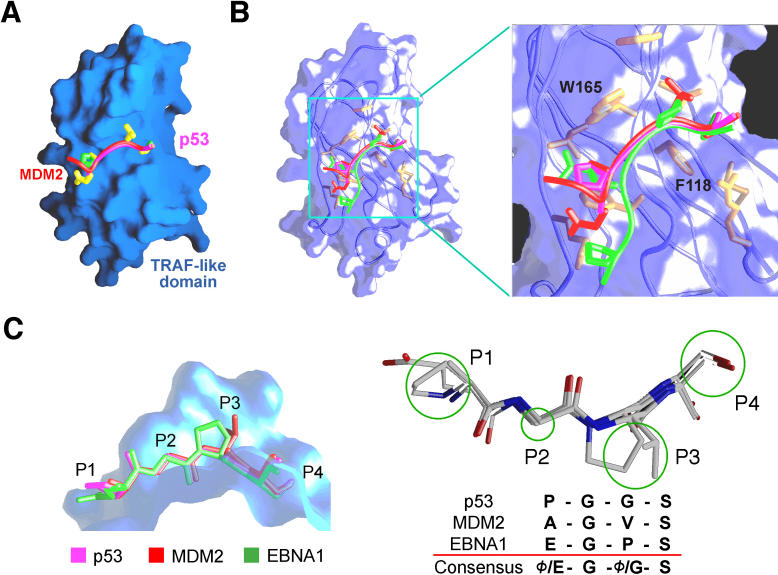
Structural Comparison of Peptide Binding by HAUSP Reveals a Consensus Sequence(A) MDM2 peptide (red) binds to the same surface groove as the p53 peptide (magenta). Residues from MDM2 and p53 are shown in yellow and green, respectively.(B) Superposition of three HAUSP-binding peptides derived from MDM2 (red), p53 (magenta), and EBNA1 (green). The HAUSP TRAF-like domain is shown in a transparent surface representation, with critical residues shown in brown.(C) Structural alignment of HAUSP-binding peptides reveals a consensus sequence. The HAUSP surface groove (in a transparent surface representation) for binding to the consensus tetrapeptide is shown in the left panel. The consensus sequence is shown in the right panel.